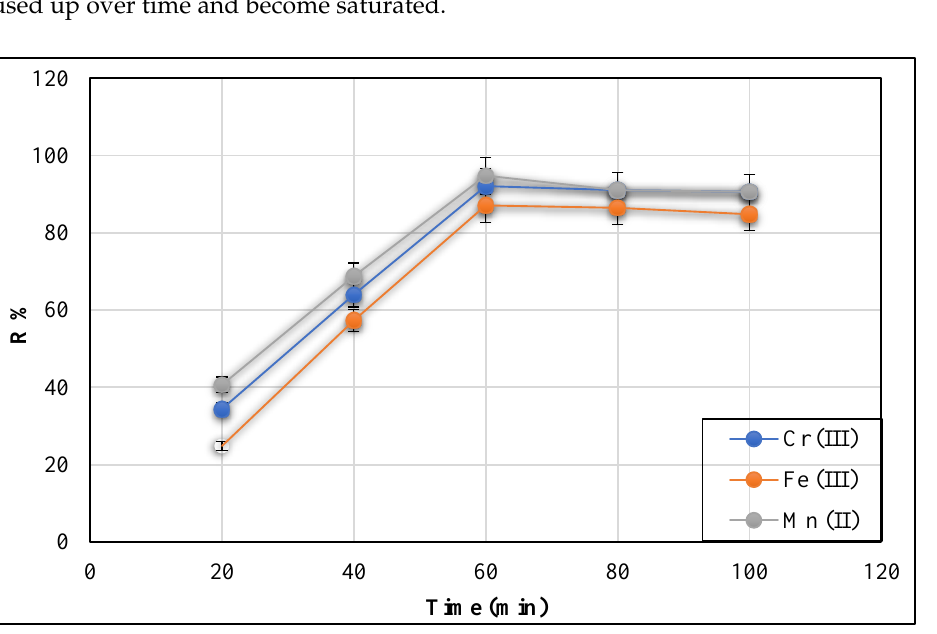
Table 3. Constants of the pseudo-first-order and pseudo-second-order models.